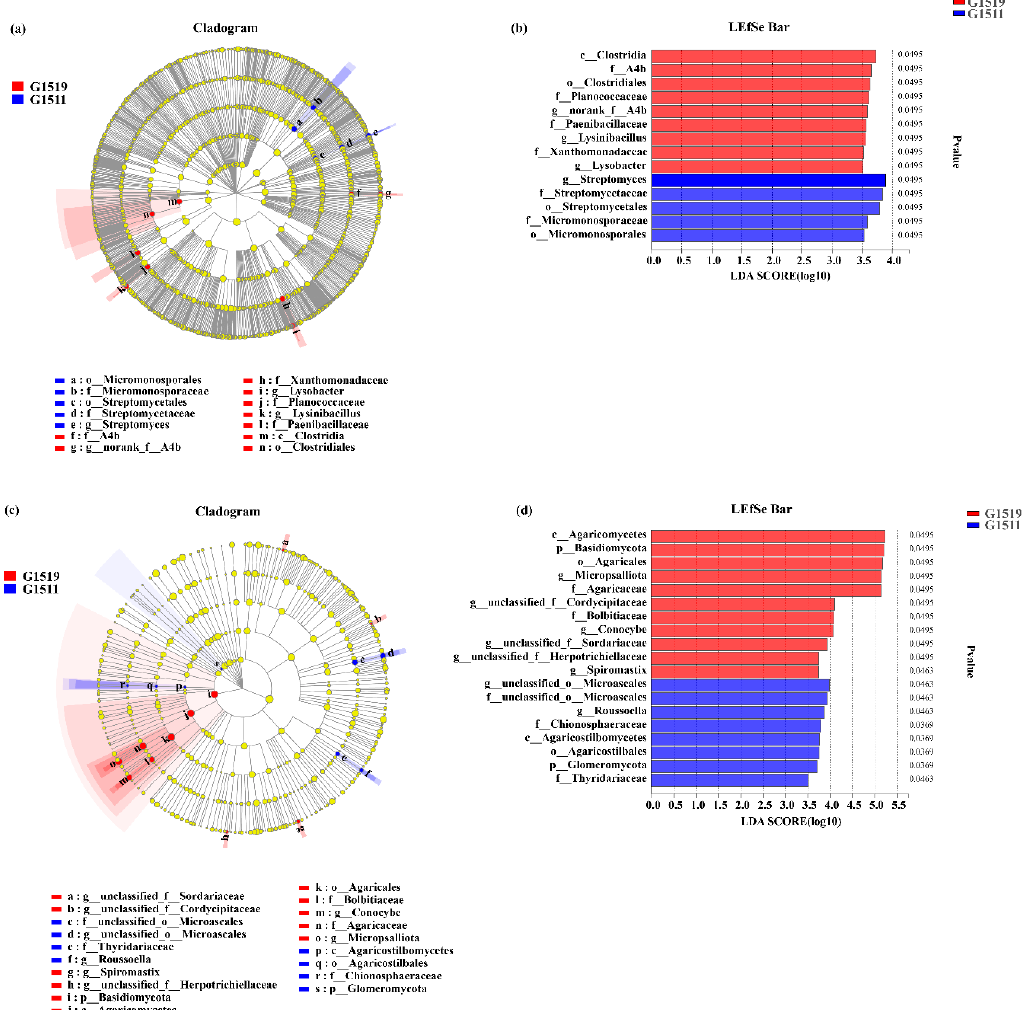
Figure 5. Phylogenetic cladogram of bacterial ( a ) and fungal ( c ) lineages in rhizosphere soil from different pumpkin cultivars (G1519 and G1511). Indicator soil bacteria ( b ) and fungi ( d ) with LDA scores of 3.5 from two pumpkin cultivars.